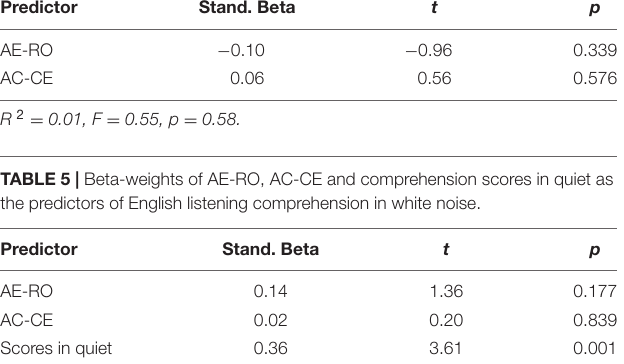
TABLE 4 | Beta-weights of AE-RO, AC-CE as the predictors of English listening comprehension in quiet Predictor Stand. Beta